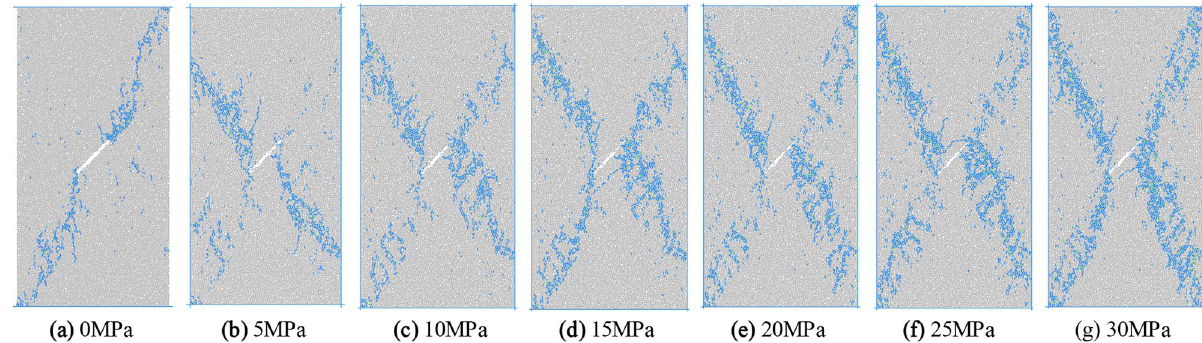
Figure 9. Failure mode of concrete under uniform load.